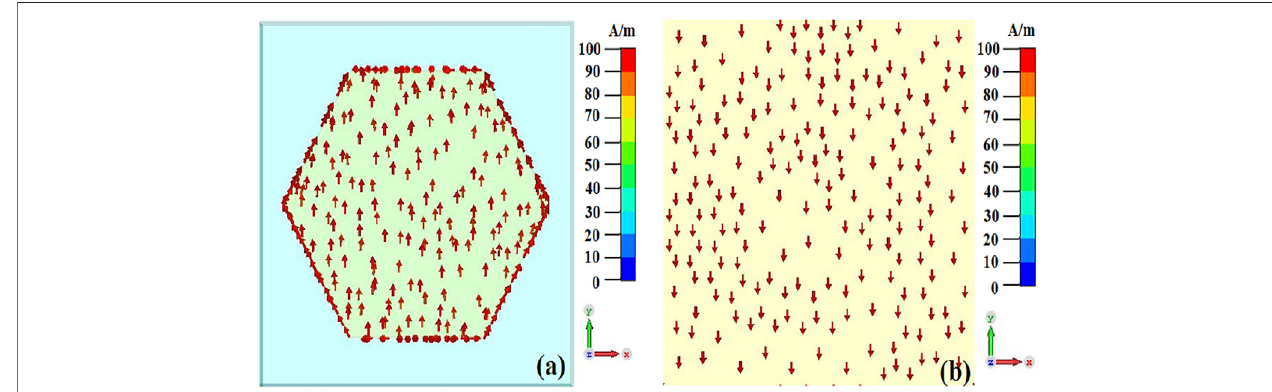
Frontiers in Materials |